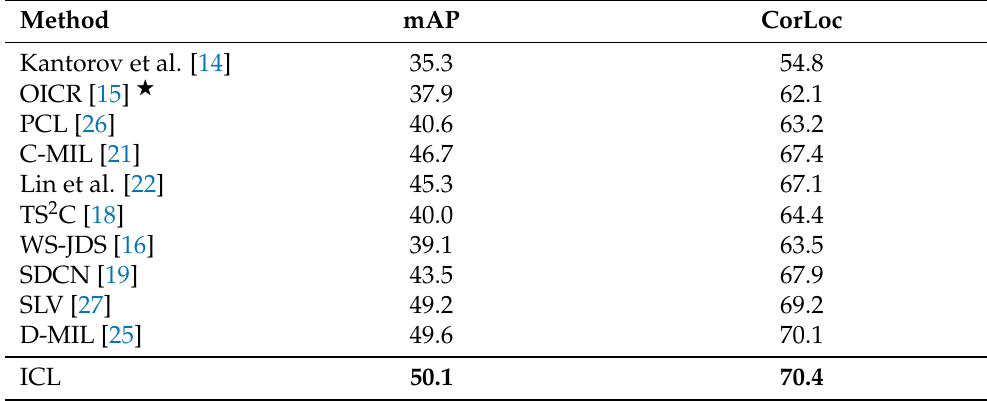
Table 3. Comparison with other methods on Pascal VOC 2012 dataset. (cid:70) means our baseline.